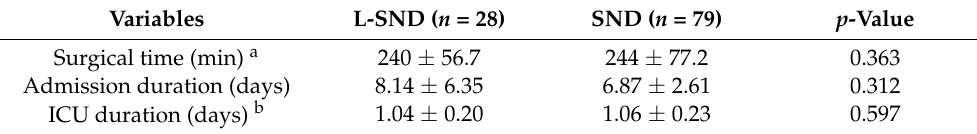
Table 2. Surgical outcomes.